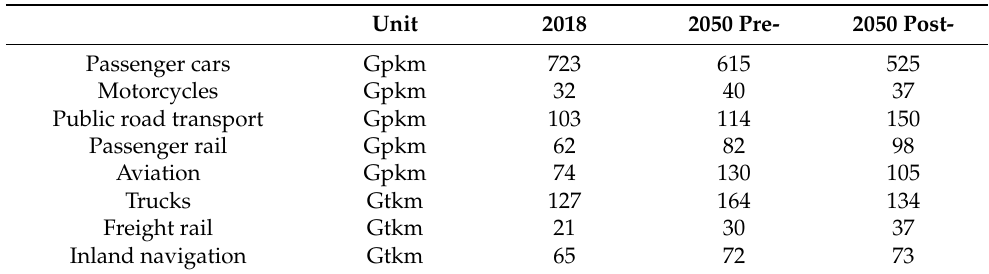
Table 4. Evolution of the demand for passenger and freight mobility in 2050, pre- and post-modal shift policies, Gpkm (passenger) and Gtkm